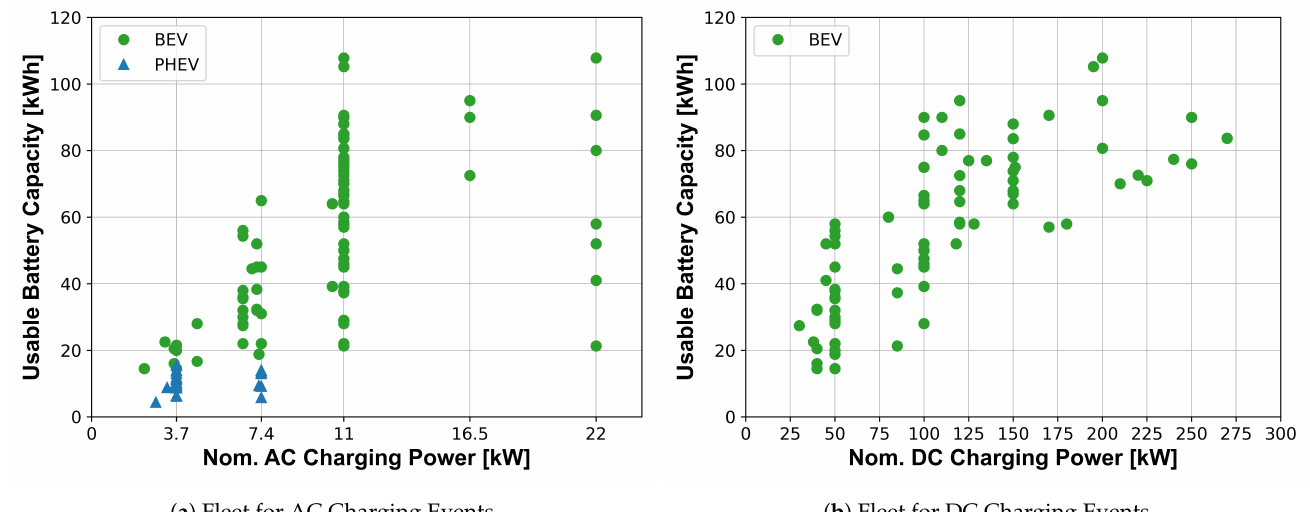
Figure 8. Usable Battery Capacity and Charging Power of the Simulated PEV Fleet.